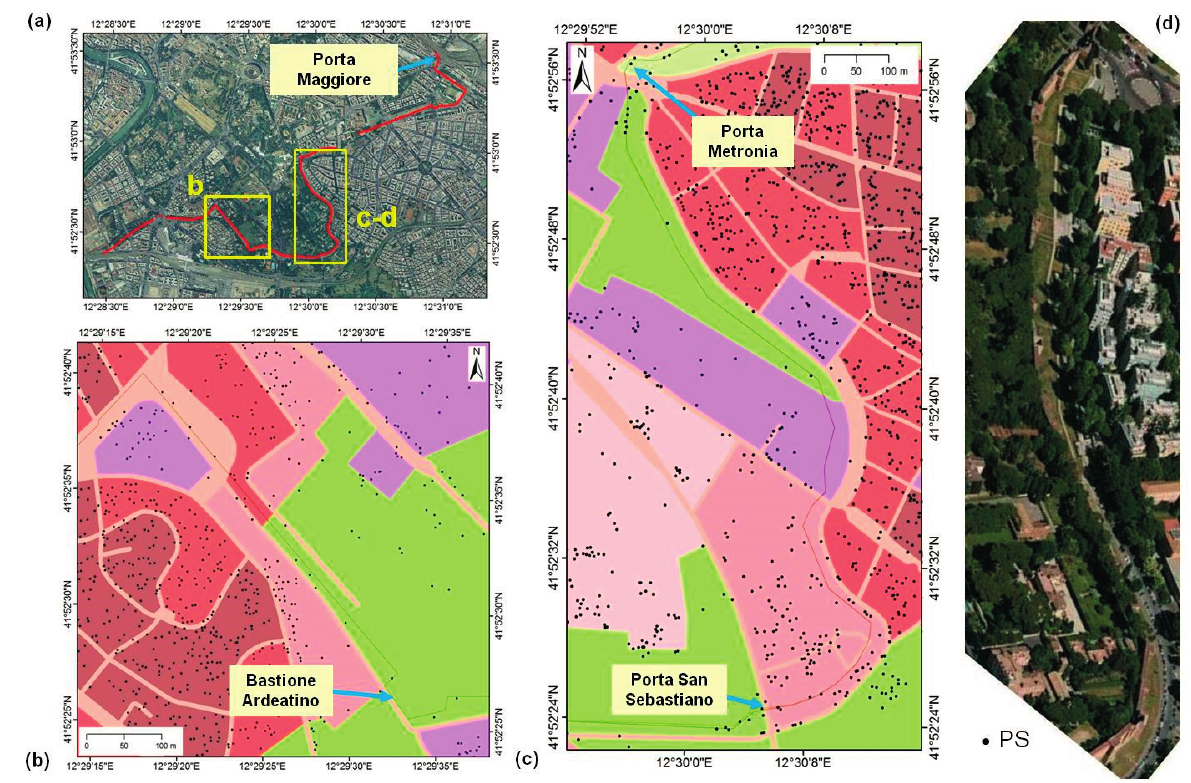
Figure 6. ( a ) Aerial view of the Southern Aurelian Walls (red line in Figure 3a) with the location of the sectors ( b ) between Bastione Ardeatino and the corner of Via Ardeatina with Via Giotto and ( c ) along Via delle Mura Latine up to Porta Metronia, with respective land cover; ( d ) aerial photograph from BingMaps (© 2014 BLOM, © 2014 Microsoft Company) showing constraints due to vegetation